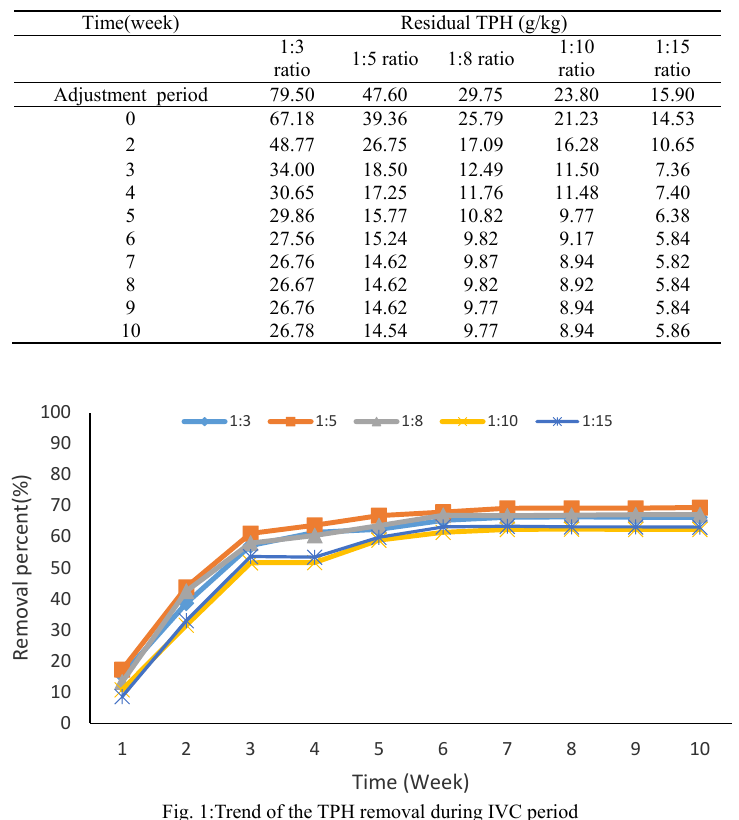
Table 3: TPH removal efficiency during IVC period